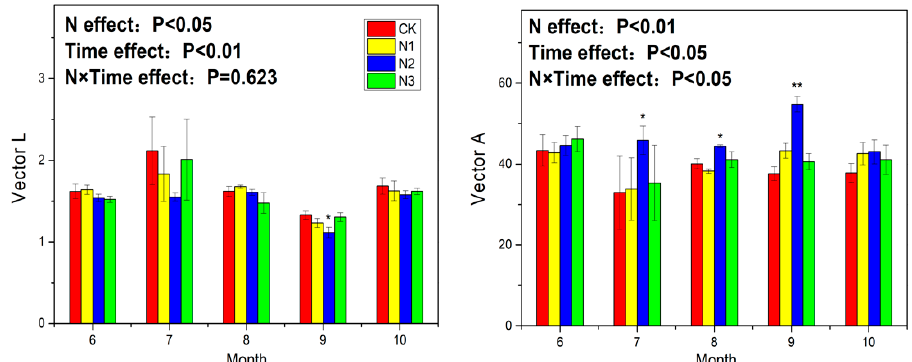
Figure 6. Responses of soil microbial relative nutrient limitation to N application in a subalpine coniferous forest. A relatively longer vector L indicates greater C limitation, and vector A < 45° and >45° indicate relative degrees of N and P limitation, respectively. * indicates significant difference between N treatment and control, ** indicates extremely significant difference between N treatment and control (repeated measures ANOVA, LSD multiple comparison).